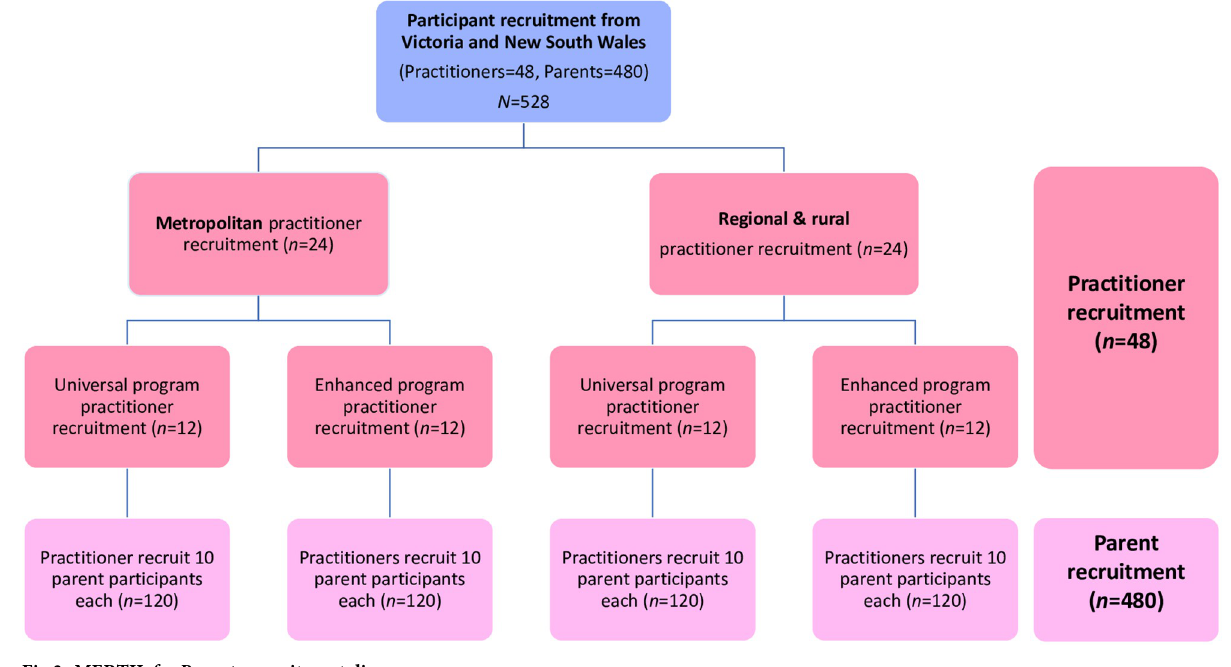
Fig 3. MERTIL for Parents recruitment